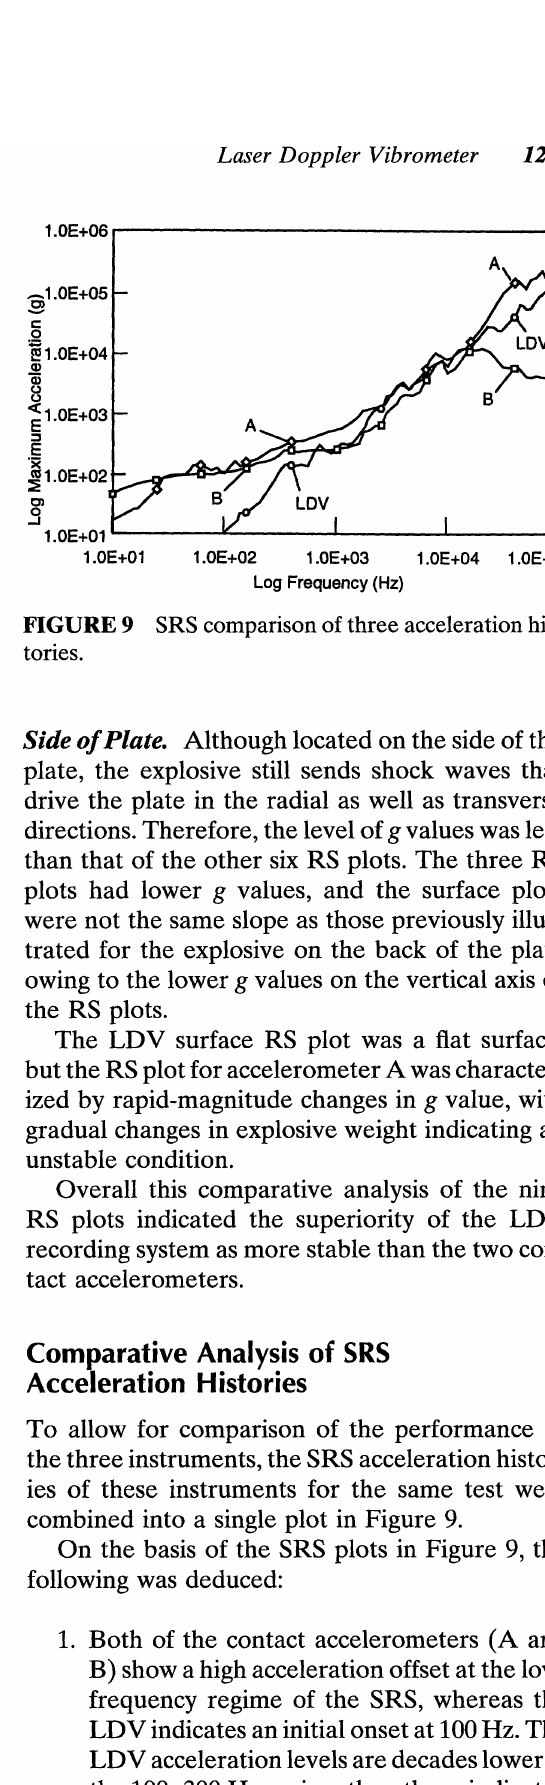
FIGURE 8 RS plot, accelerometer A (explosive on back of plate).